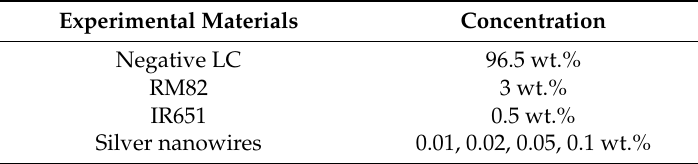
Table 1. Proportion of materials required for the experiment 120